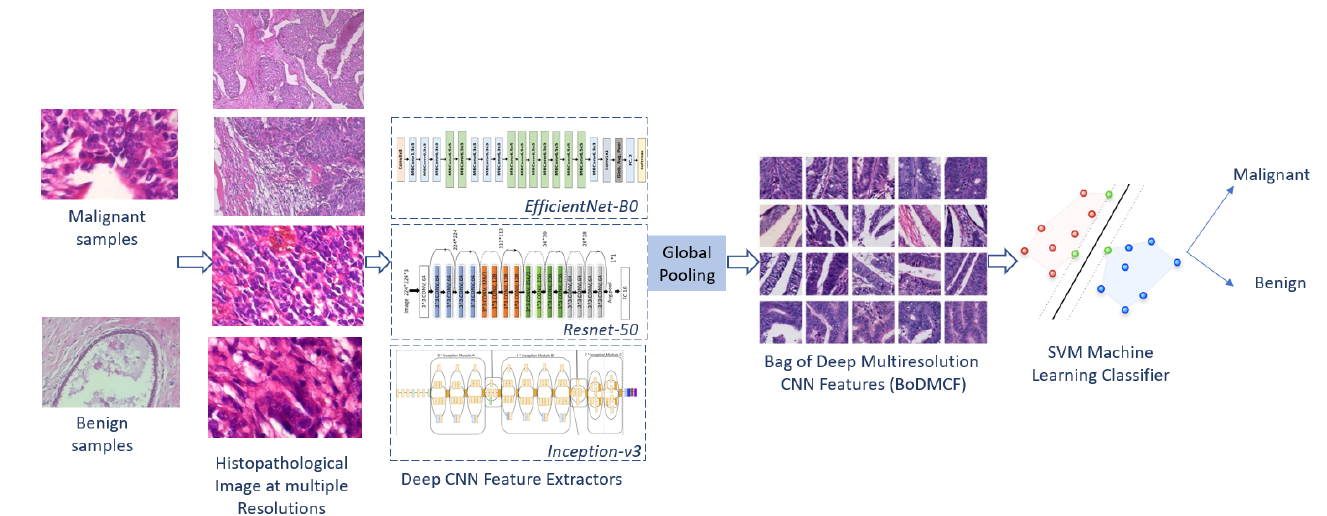
Figure 6. Our proposed approach: A bag of multiresolution CNN features (BoDMCF) are extracted from multiple resolutions of samples of malignant and benign histopathological images, which are then classified using a support vector machine (SVM) classifier.